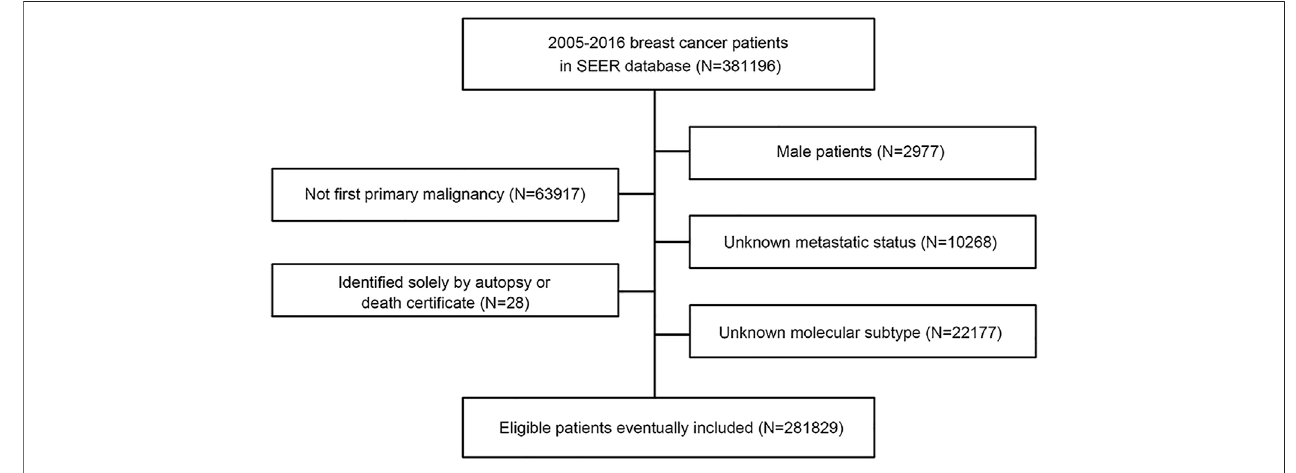
FIGURE 1 | Flowchart of the inclusion of patients in SEER